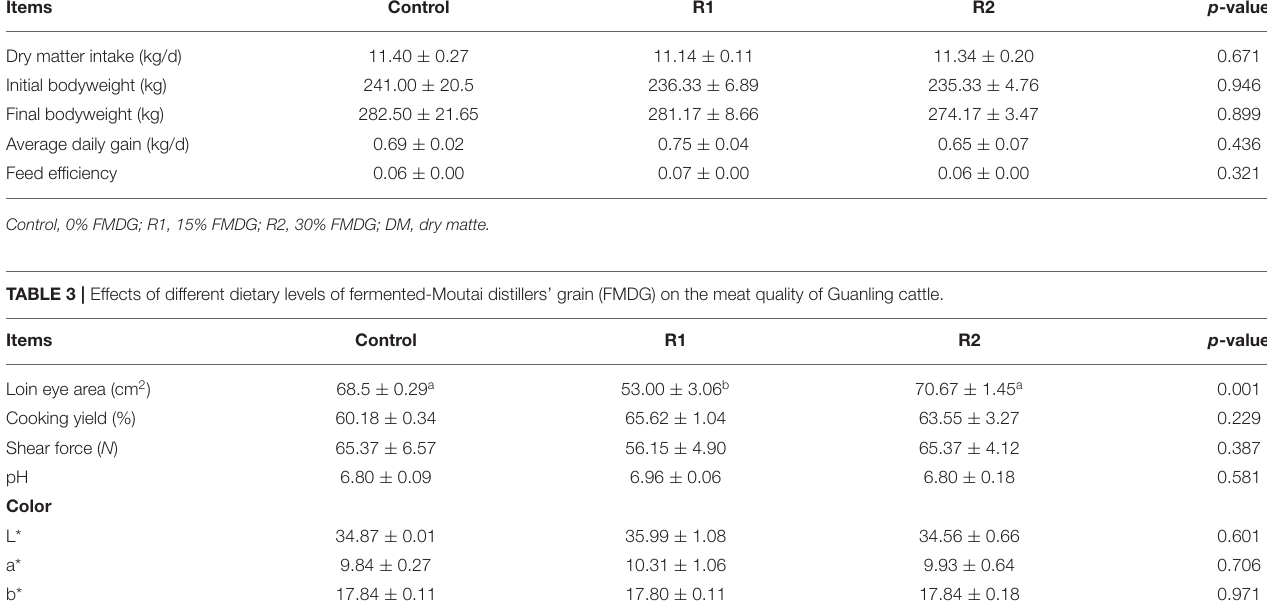
TABLE 2 | Effects of different dietary levels of fermented-Moutai distillers’ grain (FMDG) on the growth performance of Guanling cattle. Items